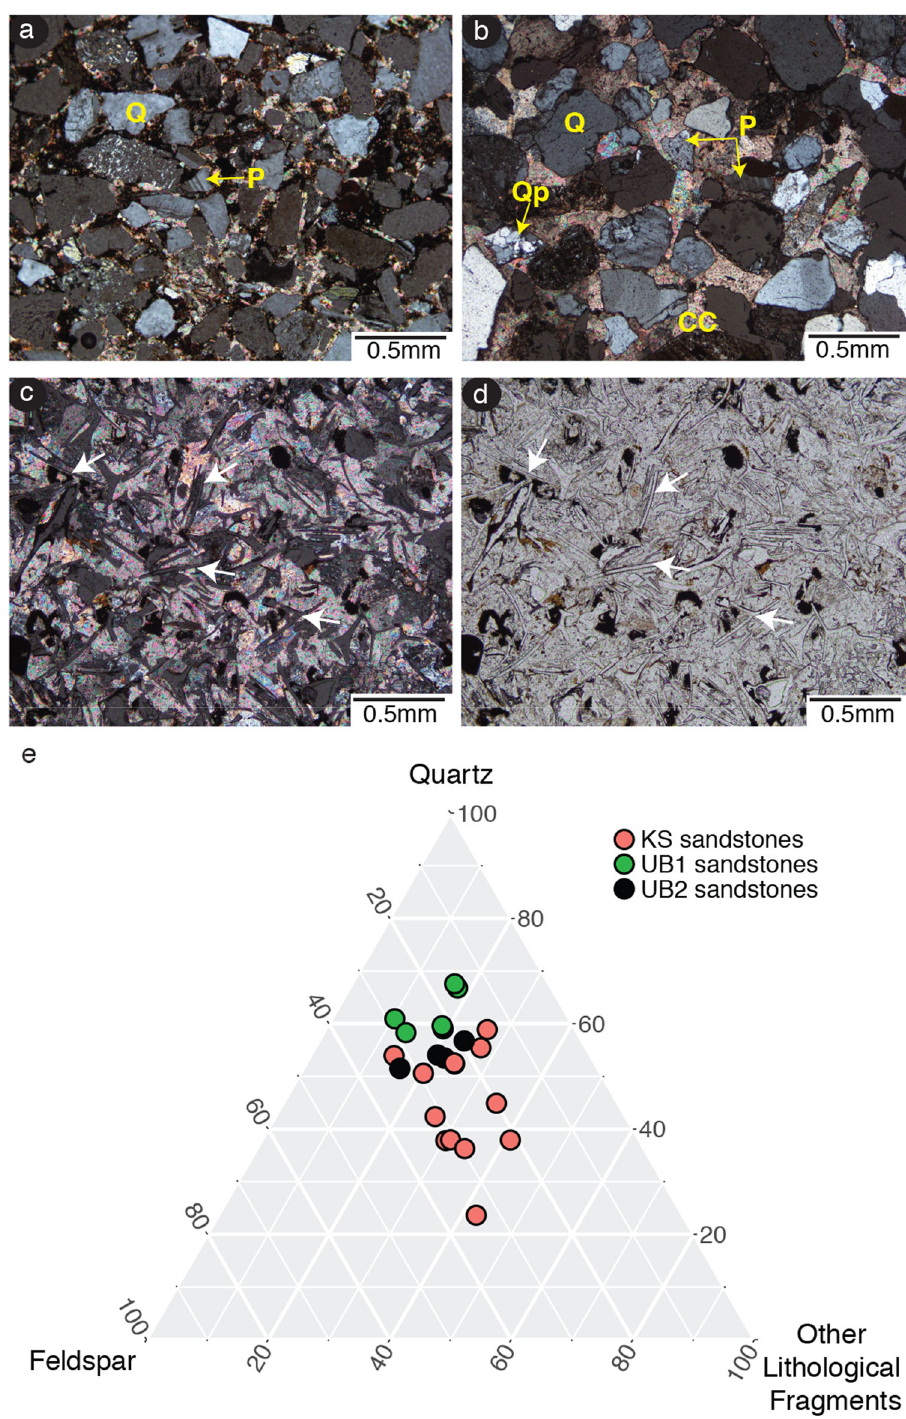
Fig. 4 Mineralogy of Burgi Member ( n = 11) and KBS Member ( n = 12) sandstone thin-sections from Area 13. a The UB1 sandstone lamination fabric as seen through the parallel arrangement of minerals with subrounded moderately sorted grains embedded in a calcite cement in cross-polarized light. b KS sandstone occurrences showing poorly sorted, angular grains of an immature sediment with distinct mineralogy as demonstrated by the presence of igneous rock fragments. UB2 sandstone spicules of megascleres sponges with monaxon and triaxon forms in c cross-polarized and d plane-polarized light. e A QFL ternary plot showing percent composition of upper Burgi (UB1, UB2) and KBS (KS) sandstones sampled in Area 13. CC: calcite cement, P: plagioclase, Q: quartz, Qp: polycrystalline quartz, white arrows: examples of sponge spicules. The source data underlying Fig. 4e are provided in the Source data fi